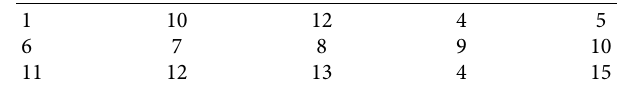
Table 2: Artifcial data T for Example 2.